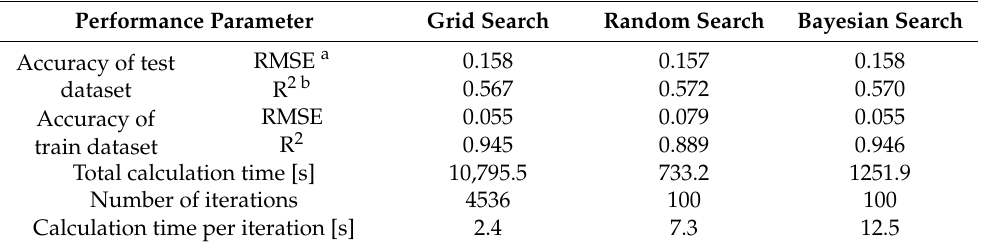
Figure 6. Mean validation score and fitting time for three hyperparameter optimization algorithms. Table 5. Accuracy and calculation times for three hyperparameter optimization methods.